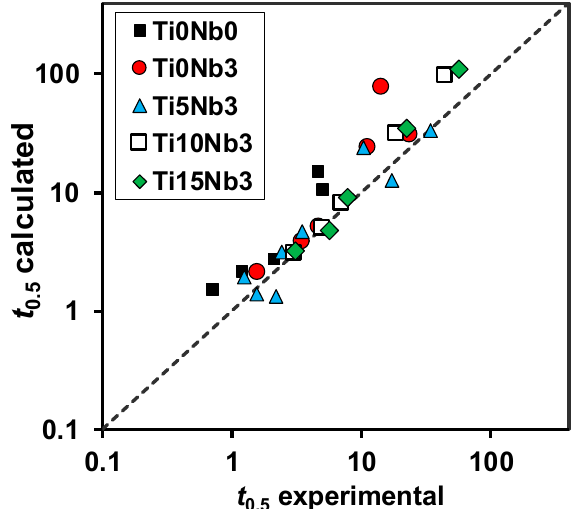
Figure 16. Comparison between the experimental t 0.5 and the values predicted using Equation (2) .